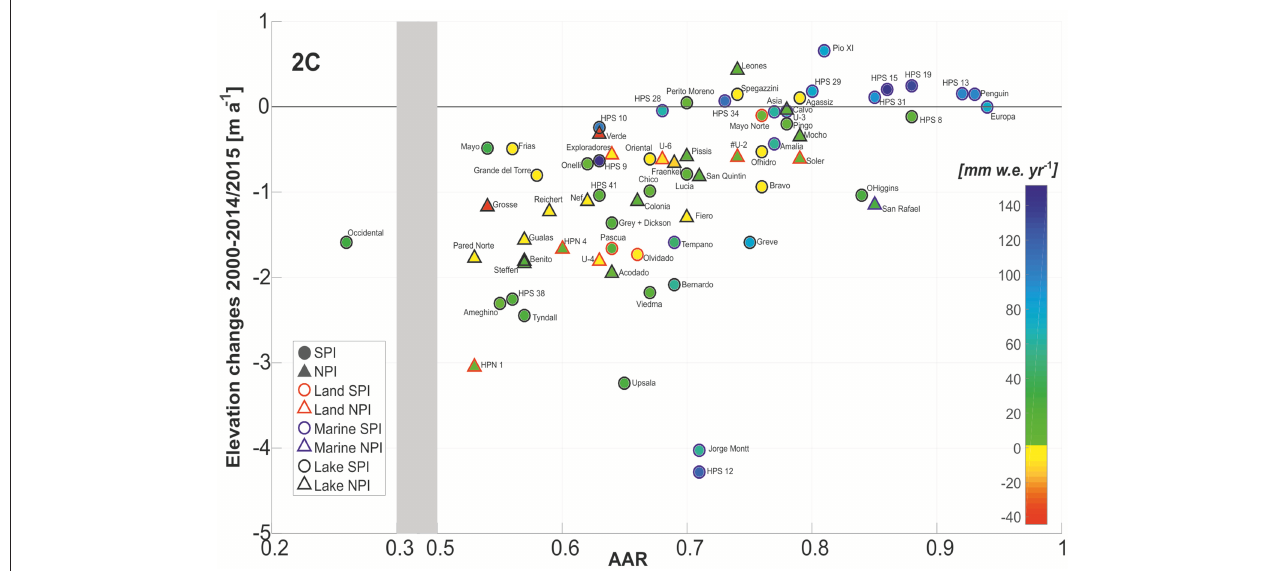
FIGURE 9 | Observed elevation changes in the period 2000–2014/2015 for both icefields vs. the accumulation-area ratio (AAR). The color represents the snow accumulation trends by glaciers using the 2C as PPM. Terminus type is also indicated depending the color of the contour for each symbol, triangle for the SPI, and circle for the NPI (see legend). Note that the x-axis is broken. Due to space issues some glaciers names are not